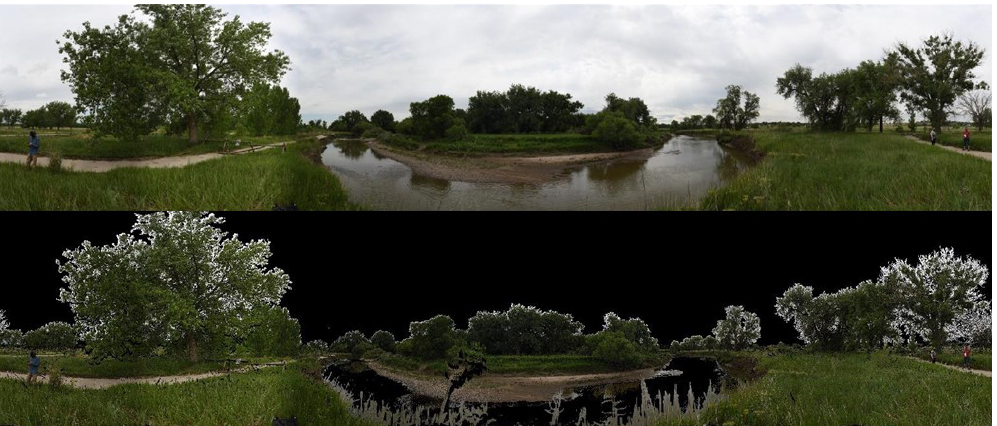
Figure 3. The top shows the terrestrial laser scanner photograph from a scan location, whereas the bottom shows the associated point cloud at the Cache la Poudre River site. Courtesy of